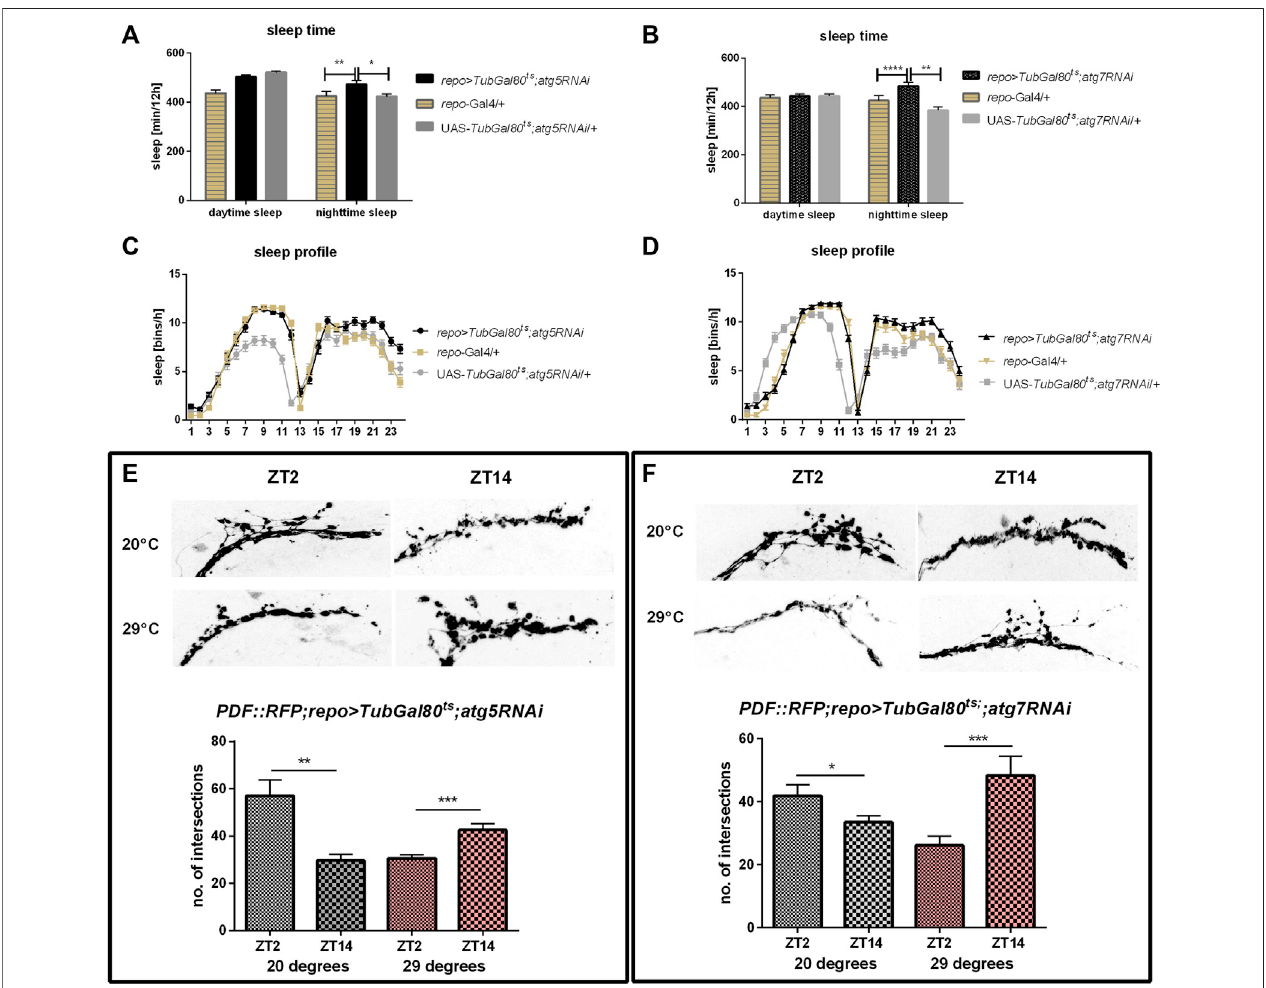
FIGURE2| Effect of pan-glial autophagy disruption. (A – D) : Effect of silencing of atg5 or atg7 in glia on sleep level. Changes were observed only during the night. (E,F) : Autophagy disruption in glia affects daily plasticity of sLNvs terminals arborisation complexity. Statistically signi fi cant differences marked as asterisks * p ≤ 0.05, ** p ≤ 0.01, *** p ≤ 0.001, **** p ≤